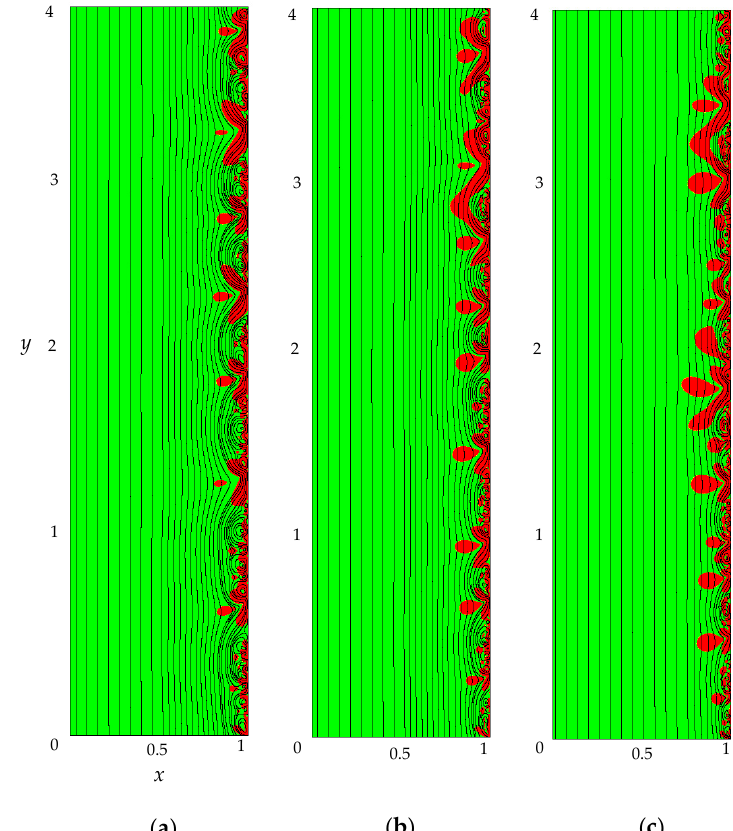
Figure 10. Solution streamlines (black lines) and electroconvective mixing layer (red color) at t = 17. The results of calculation for c 0 = 0.1 mol/m 3 ( a ), 0.3 mol/m 3 ( b ), 1 mol/m 3 ( c ) at i av / i lim = 2.